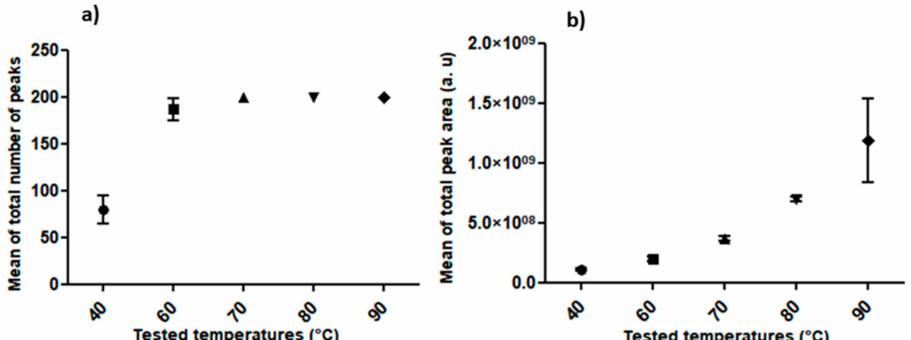
Figure 2. ( a ) Mean of the total number of volatile organic compound peaks and ( b ) of the total peak area of volatile organic compounds detected via chromatographic analysis using the tested fiber types during the solid-phase microextraction step. Carboxen / polydimethylsiloxane (CAR / PDMS), polydimethylsiloxane (PDMS), polydimethylsiloxane / divinylbenzene (PDMS / DVB).